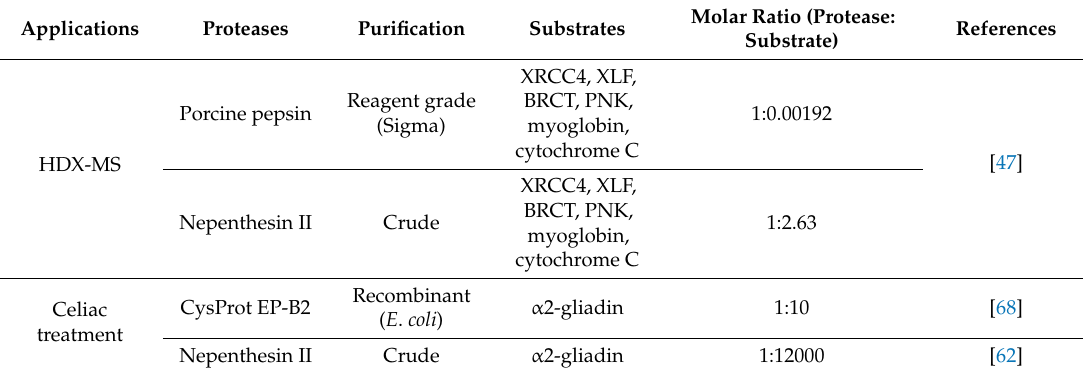
Table 2. Comparison of the proteolytic e ffi ciency of nepenthesin to other proteases used for industrial